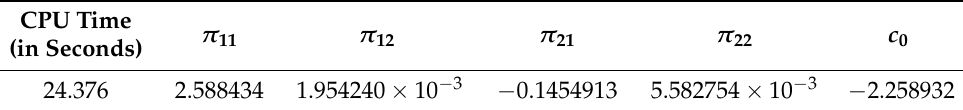
Table 7. Result of implementation of nlstac for pattern (17) taking a tolerance of 10 − 12 , the number of divisions as 10 and [ 0,10 − 4 ] and [ 2 × 10 − 4 ,10 − 3 ] as the intervals where to seek, respectively, the nonlinear parameters γ 1 and γ 2 .